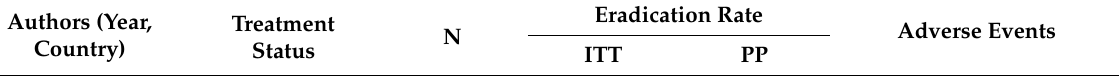
Table 2. Results of vonoprazan-based regimens for Helicobacter pylori eradication